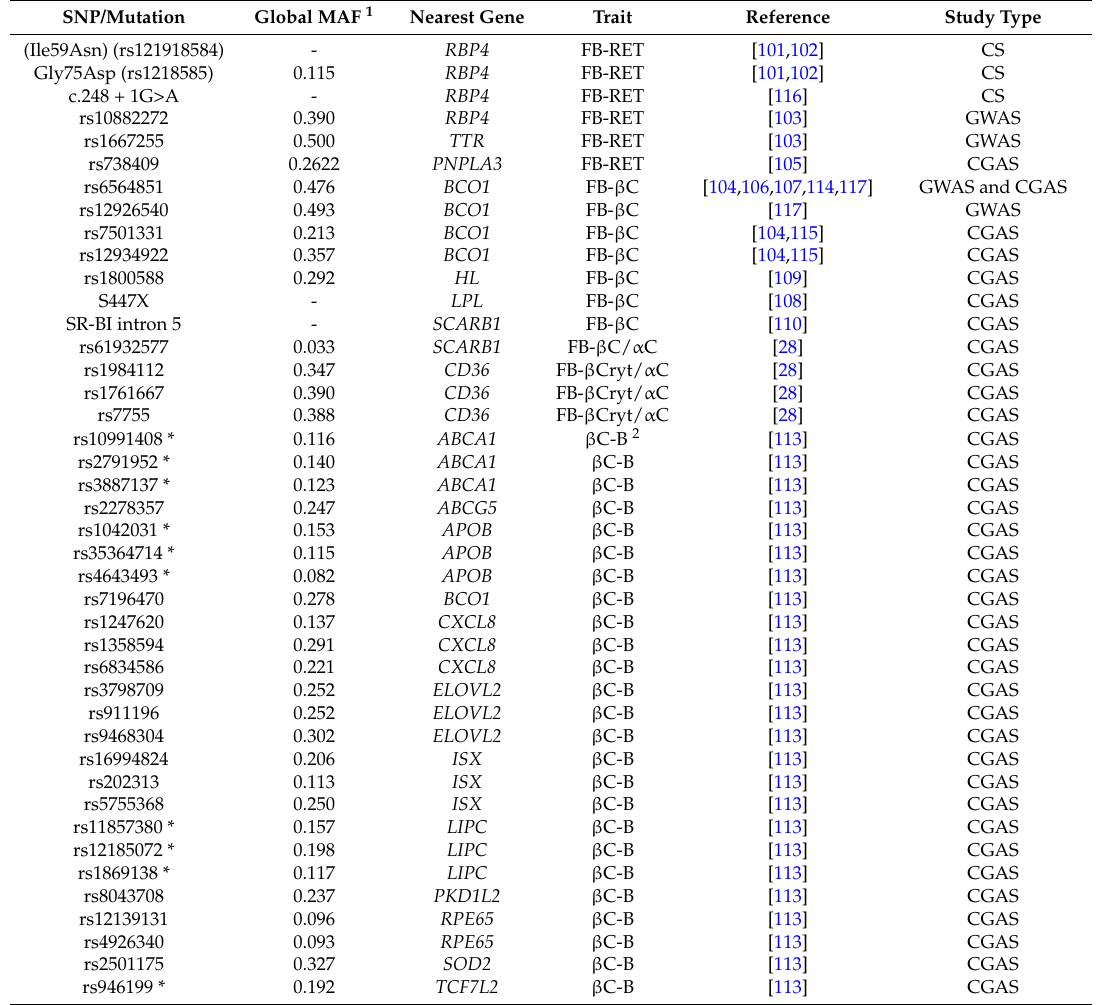
Table 1. Summary of SNPs associated with fasting blood vitamin A concentration or vitamin A